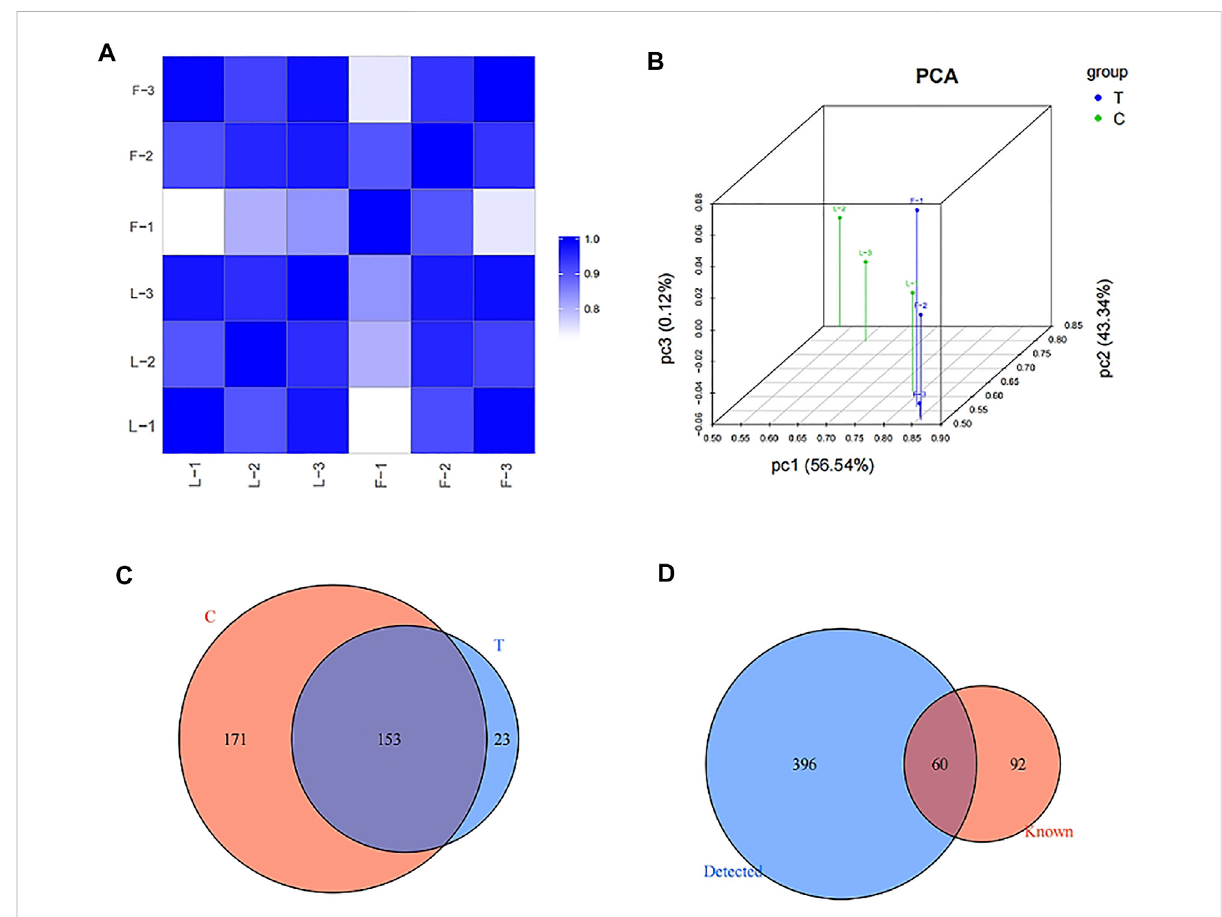
FIGURE 2 Expressionpro fi lesoftRFs/tiRNAsintheExo-LTandExo-ATgroups. (A) Heatmapshowingthecorrelationcoef fi cientoftRFsandtiRNAsfromall the samples. Blue represents two samples with high correlation coef fi cient, while white represents the two samples with low correlation coef fi cient. (B) Principal component analysis (PCA) of tRFs and tiRNAs from all the samples. The colored points represent the corresponding samples, and the space distance represents thesimilarityin data size. (C) Venn diagram based on the number ofcommonly expressedand speci fi cally expressed tRFs/tiRNAsbetween theExo-AT(C) and Exo-LT(T) groups. (D) Venn diagram basedon thenumberof known anddetected tRFs/tiRNAsdifferentially expressed between the Exo-AT and Exo-LT